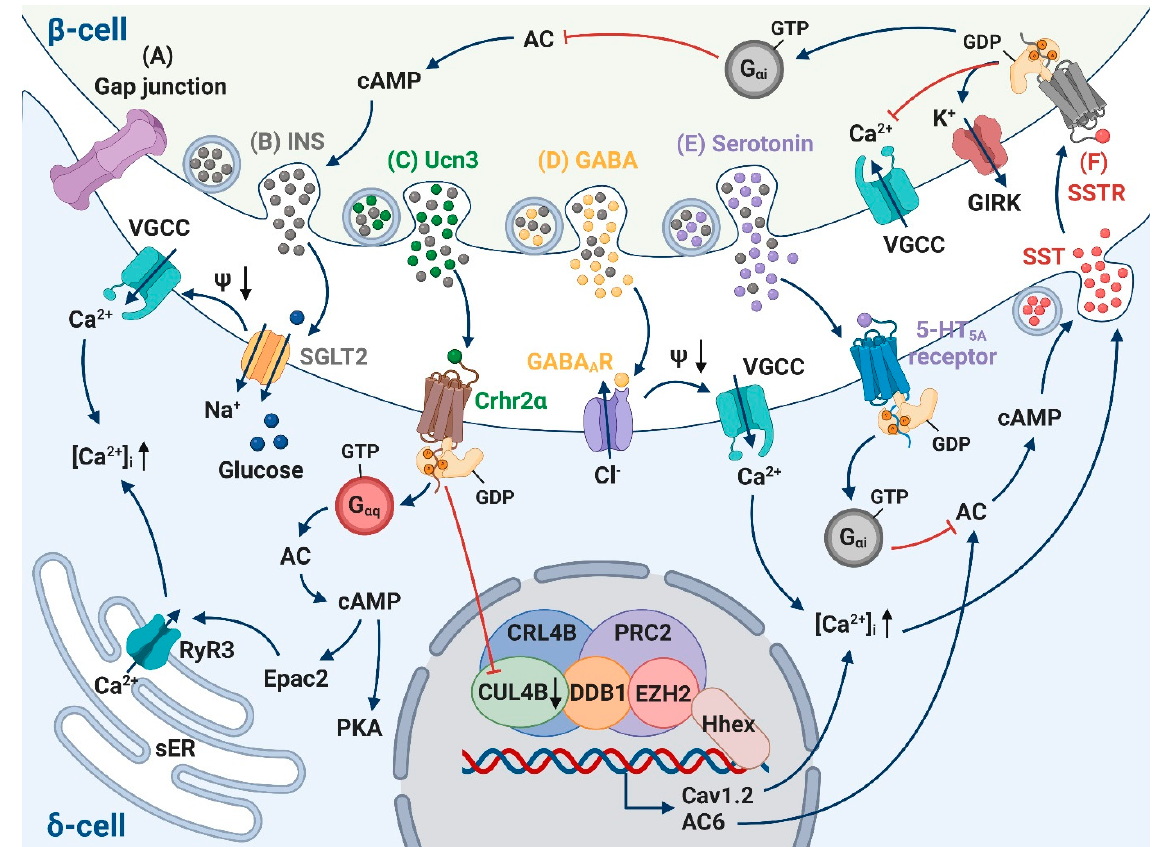
Figure 3. Paracrine interaction between β -cells and δ -cells. ( A ) δ -cells are directly coupled to β -cells via gap junction. ( B ) Insulin (grey) secreted by β -cells promotes somatostatin secretion via stimulation of sodium-dependent glucose cotransporter 2 (SGLT2). Na + -dependent glucose uptake induced by SGLT2 triggers a small depolarizing current and leads to action potential firing and opening of VGCC. ( C ) Urocortin3 (Ucn3, green, co-secreted with insulin, which is marked as grey) potentiates somatostatin release by activating type 2 corticotropin releasing hormone receptor (Crhr2) on δ -cells. The action of Ucn3 is mediated through both the cAMP-dependent pathway and epigenetic regulation of a super-complex comprising cullin 4B-RING E3 ligase (CRL4B) and polycomb repressive complex 2 (PRC2). In response to Ucn3 stimulation, the decreased expression of cullin 4B (CUL4B) and subunit histone-lysine N-methyltransferase EZH2 releases the repressive role of the CRL4B-PRC2 complex in the expression of Cav1.2 and adenylyl cyclase 6 (AC6), thereby increasing levels for second messengers Ca 2+ and cAMP and ultimately leading to increased somatostatin secretion. ( D ) γ -Aminobutyric acid (GABA, yellow, co-secreted with insulin, which is marked as grey), via GABA A receptors (GABA A Rs), induces membrane depolarization and facilitates Ca 2+ entry via VGCCs. ( E ) Upon serotonin (purple, co-secreted with insulin, which is marked as grey) binding, 5-hydroxytryptamine receptor 5A (5-HT 5A receptor) signals via G α i to inhibit AC, thus diminishing intracellular cAMP and inhibiting somatostatin secretion. ( F ) The downstream signaling of somatostatin (SST, red) activation of somatostatin receptor (SSTR) on β -cells involves activating the coupled G α i protein leading to decreased cytoplasmic levels of cAMP; hyperpolarizing the membrane potential and inhibiting action potential firing via G protein-coupled inwardly rectifying K + (GIRK) channels; inhibiting Ca 2+ influx through voltage-gated P/Q-type Ca 2+ channels. RyR3, ryanodine receptor 3; cAMP, cyclic AMP; PKA, protein Kinase A; sER, smooth endoplasmic reticulum; INS, insulin; SST, somatostatin. Created by BioRender.com.